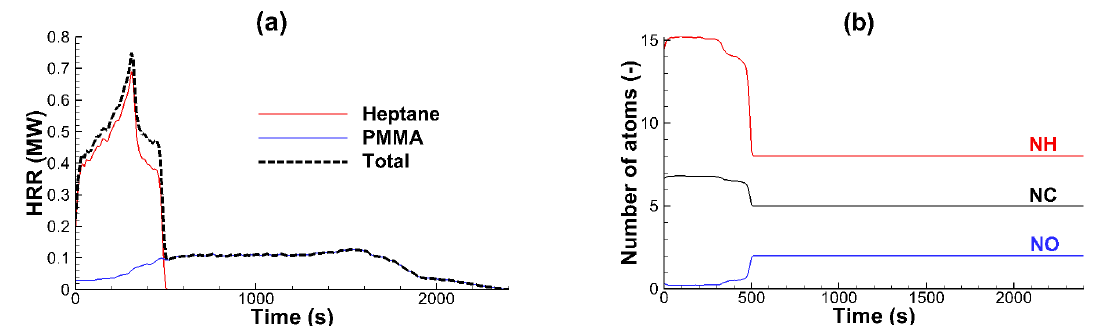
Figure 4. Time evolutions of ( a ) individual and total pyrolysis rates and ( b ) SFM, for a fire involving heptane and PMMA.